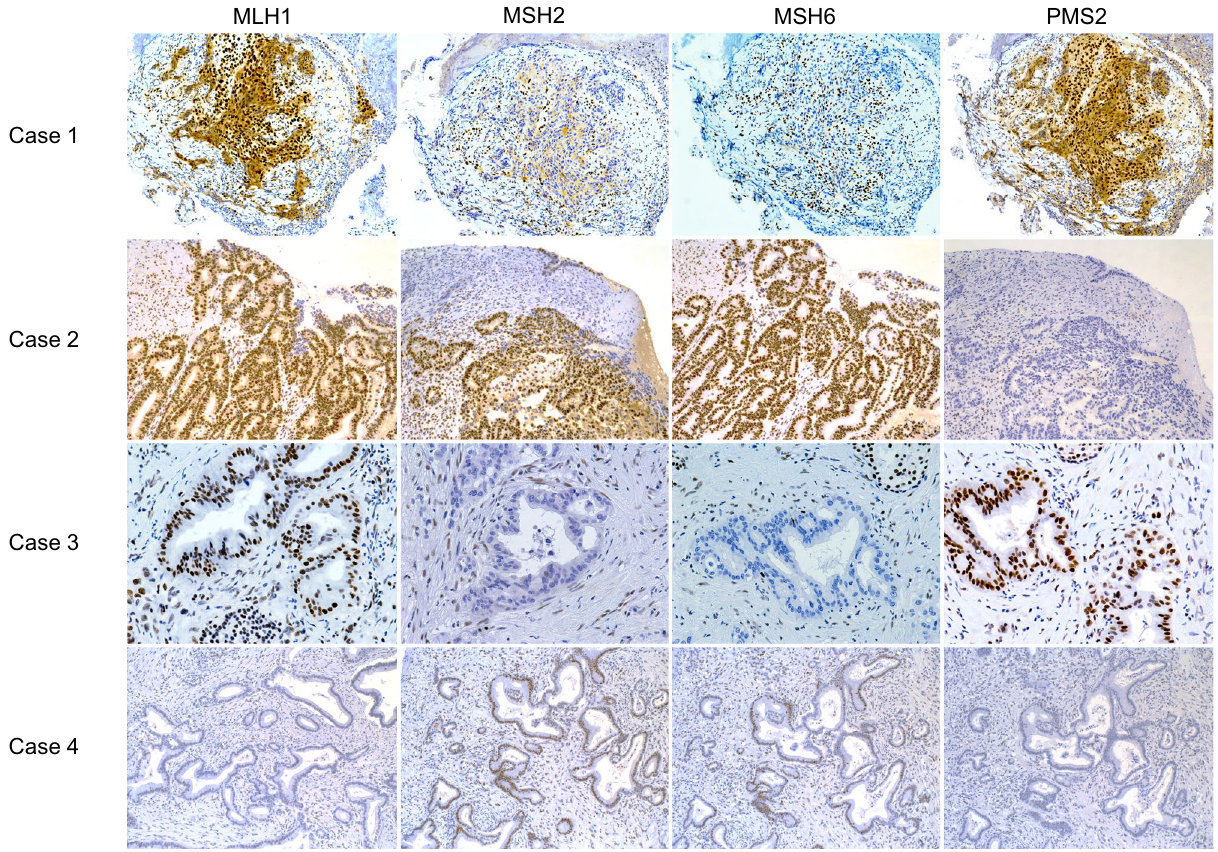
Figure 2. Immunohistochemistry staining of representative cases with MSI-H/dMMR solid